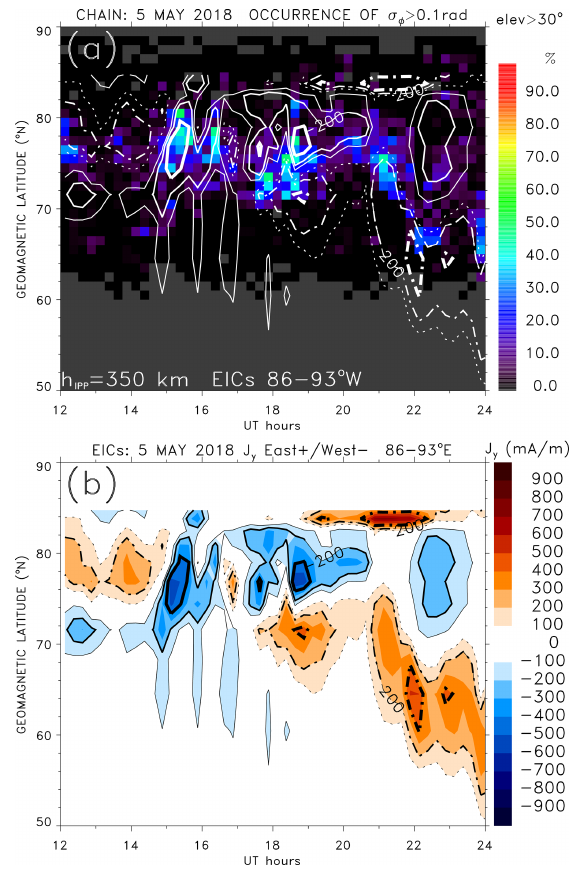
Figure 17. Panel (a) shows the GPS phase-variation occurrence as a function of AAGCM latitude and universal time (UT) on 6 March 2016. Contours of the westward and eastward EICs are shown in white solid and broken lines, respectively. Panel (b) shows the westward and eastward EICs in blue and brown shades.